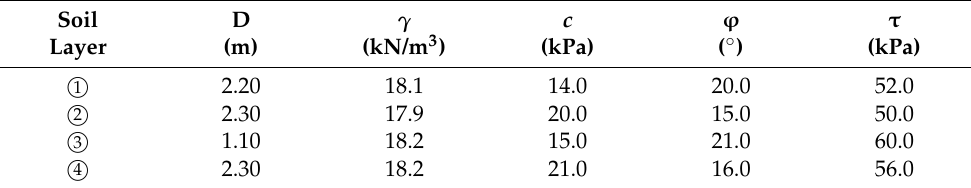
Table 2. Design parameters of soil nailed retaining structure.